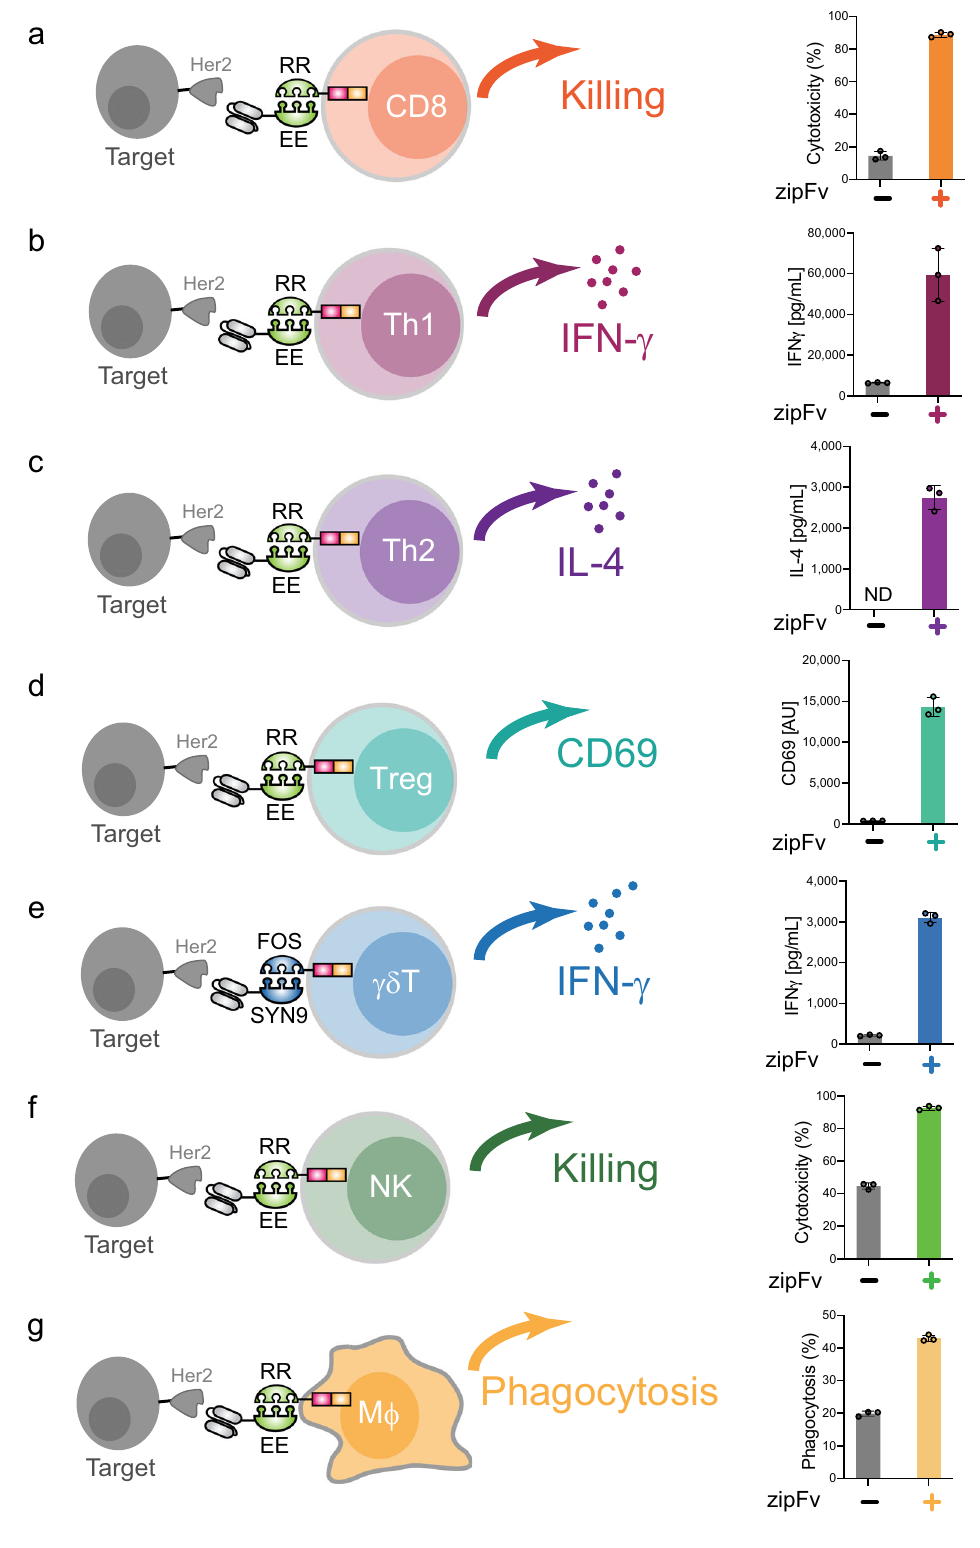
(TCR) composed of a γ -chain and a δ -chain. γδ T cells are a promising cell host for CAR immunotherapy against solid tumors because of their tissue-homing ability 13 . Moreover, γδ T cells can be obtained from healthy donors as an allogeneic cell source because the γδ TCRs are not speci fi c to donor patient ’ s proteins and therefore its allograft has quite low risk of graft-vs-host disease (GvHD) 14,15 . We showed that SUPRA CAR γδ T cells